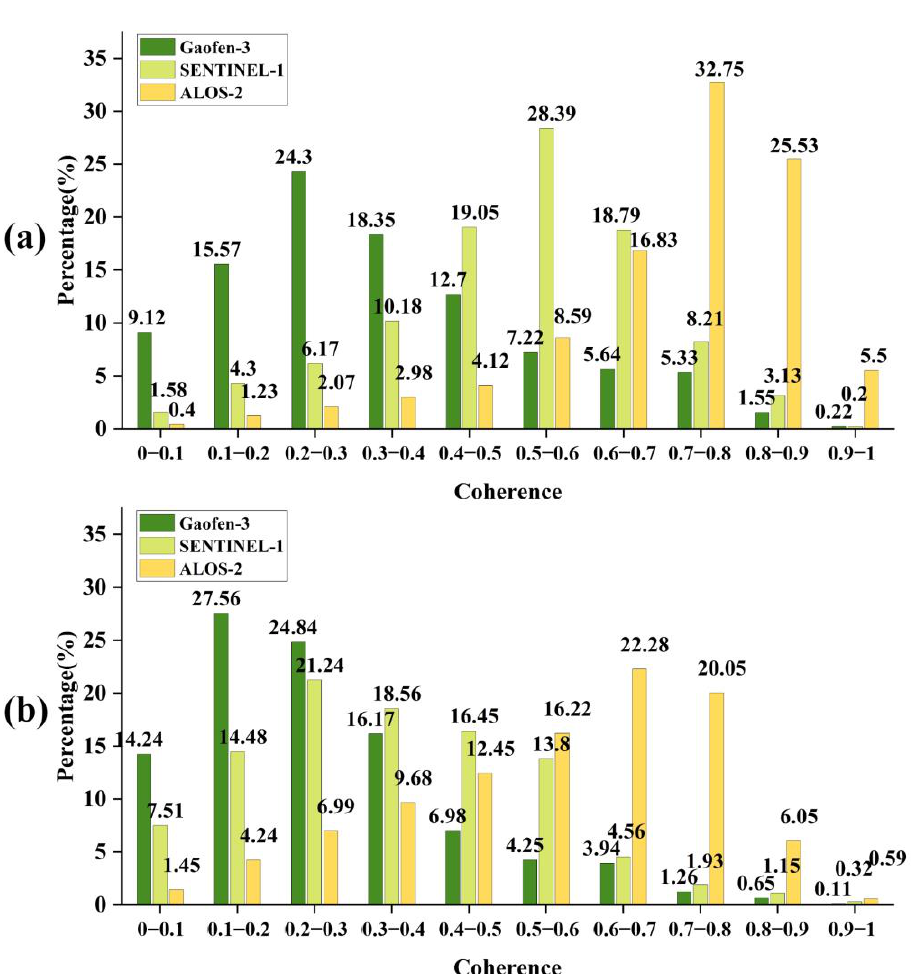
Figure 7. ( a ) Statistical analysis of the first coherence group (Gaofen-3 28 Decemver 2020 – 26 January 2018). ( b ) Statistical diagram of the second coherence group (Gaofen-3 26 January 2021 – 23 April 2018).